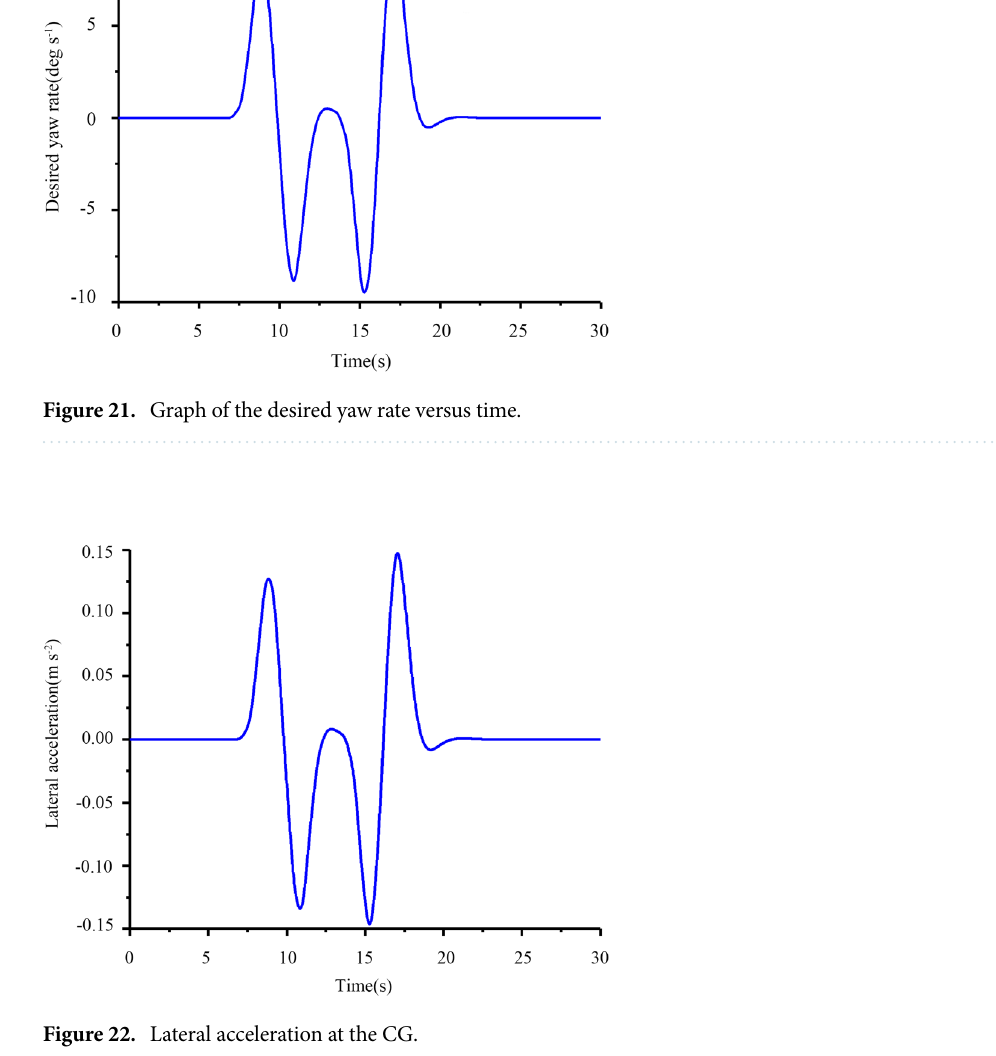
Figure 22. Lateral acceleration at the